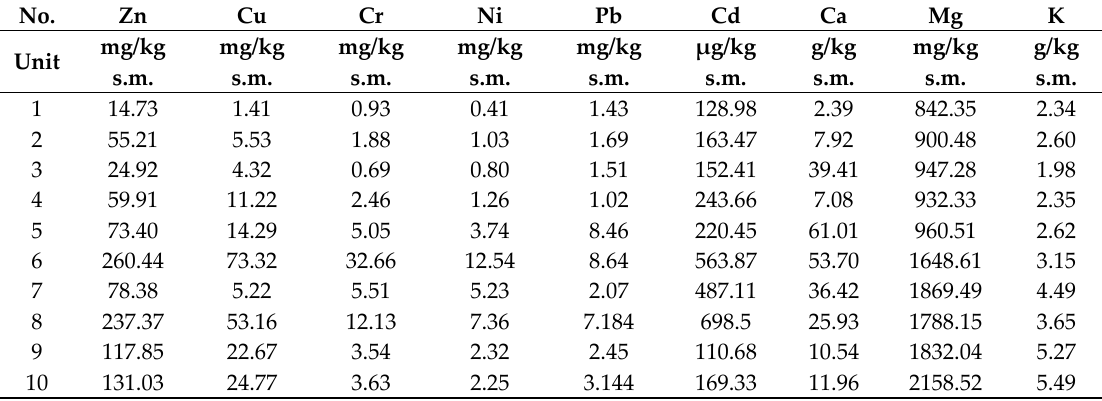
Table 1. Content of heavy metals and macronutrients in the tested samples.